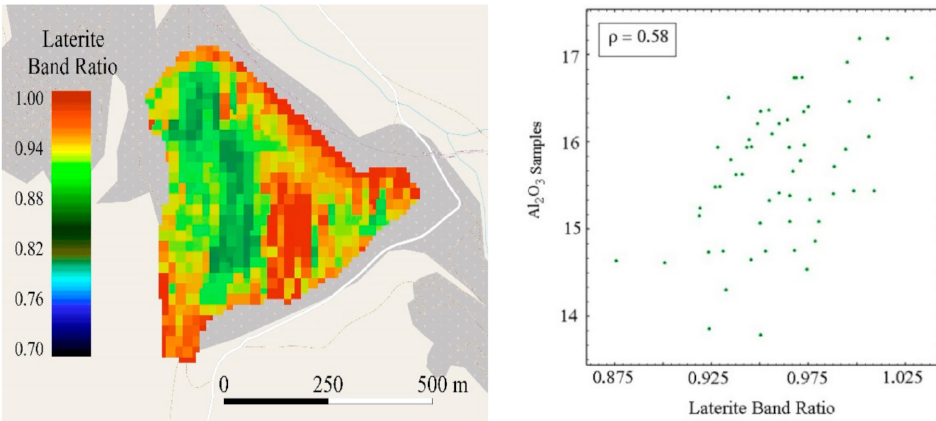
Figure 7. Laterite band ratio applied to Sentinel-2-Images ( Left ) and the correlation coefficient between samples and laterite band ratio values ( Right ) (30 July